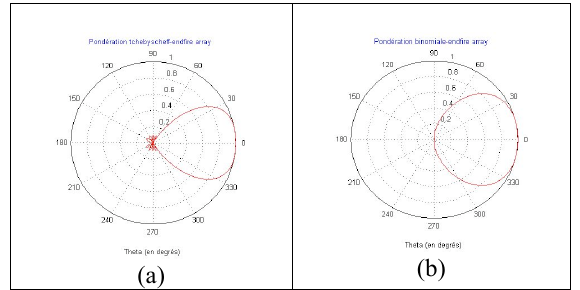
Fig. 3. Directivity diagrams for Dolph-Tchebychev (a) and binomial (b) weighting